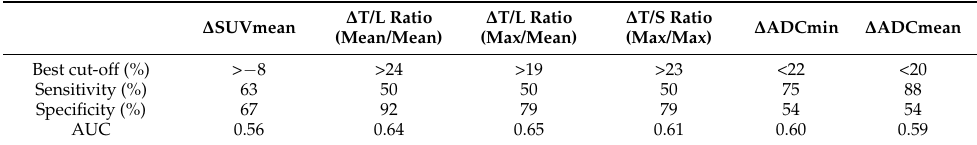
Table 6. ROC analysis of SUV and ADC for predicting HPFS < 12 months.